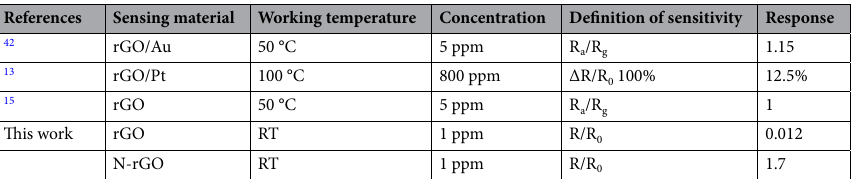
Table 1. Comparison of fabricated NO gas sensors with the previously reported NO sensor material.